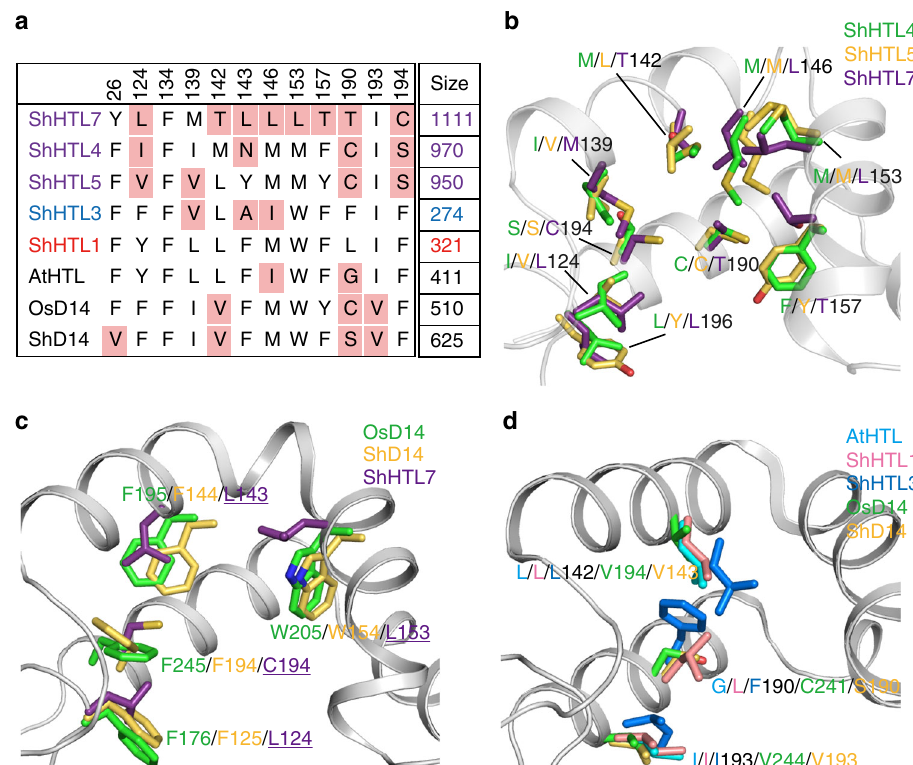
Fig. 4 Residues involved in determining the pocket size of ShHTLs and ShD14. a Residues composing the ligand-binding pocket of each HTL and D14. Font colors of purple, blue, and red represent divergent, intermediate, and conserved clades, respectively, and the background pink color represents less bulky residues. The top row represents the residue number of ShHTL7, and the right column represents the pocket size (Å 3 ). b Comparison of residues of ShHTLs of the divergent clade. Residues in the ligand-binding pockets of ShHTL4 (green), ShHTL5 (PDB code: 5CBK [https://doi.org/10.2210/pdb5CBK/ pdb]; yellow), and ShHTL7 (purple) are shown. c Residues composing the ligand-binding pockets of OsD14 (PDB code: 3W04 [https://doi.org/10.2210/ pdb3W04/pdb]; green), ShD14 (yellow), and ShHTL7 (purple) are shown. d Residues composing the ligand-binding pockets of AtHTL (PDB code: 4JYP [https://doi.org/10.2210/pdb4JYP/pdb]; cyan), ShHTL1 (pink), ShHTL3 (blue), OsD14 (PDB code: 3W04 [https://doi.org/10.2210/pdb3W04/pdb]; green), and ShD14 (yellow) are